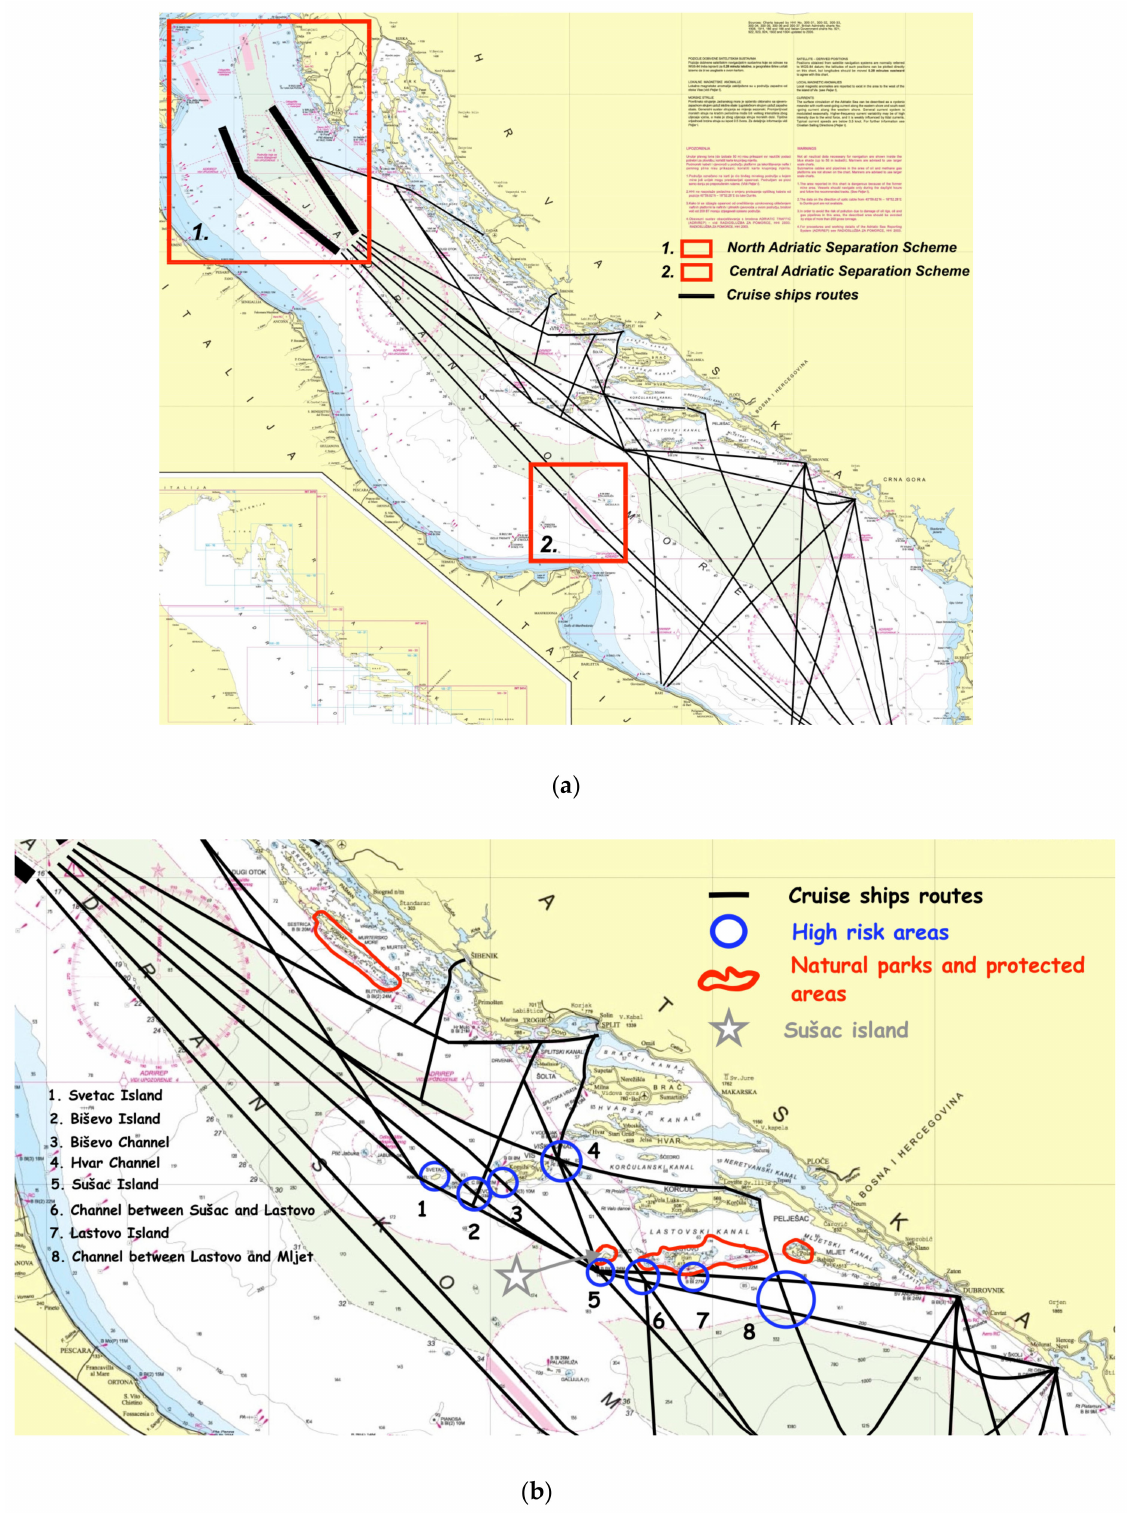
Figure 9. ( a ) Cruise traffic in the Adriatic east coast [7]. Black lines—cruise ships’ routes; red squares— red square 1: the North Adriatic Separation Scheme; red square 2: the Central Adriatic Separation Scheme. ( b ) Cruise ships’ routes and high-risk zones in the central and south part of the east Adriatic. Black lines—cruise ships routes; red squares—red square 1: the North Adriatic Separation Scheme; red square 2: the Central Adriatic Separation Scheme; red curves—marine protected areas; grey star—the island of Sušac; blue circles—areas of high navigational